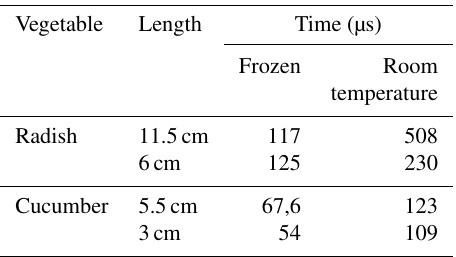
Table 2. Change in delay based on the physical state and length of the sample